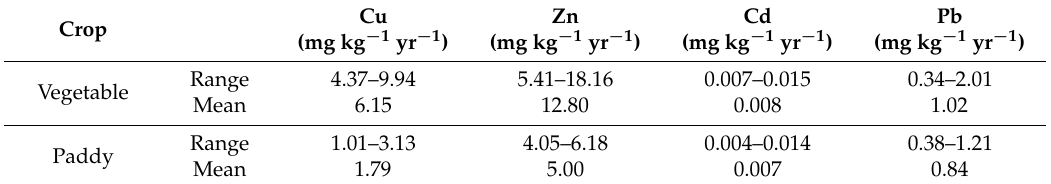
Table 8. Average cumulative rate of heavy metals in croplands in the vicinity of sample pig farms.